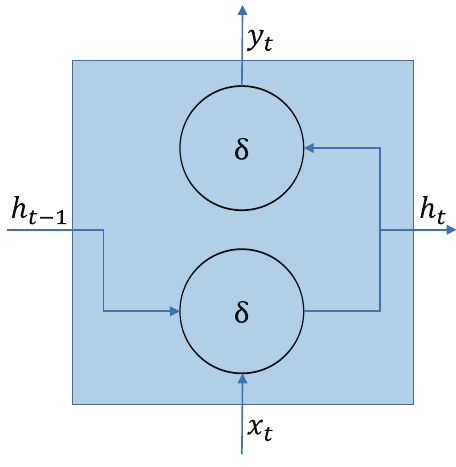
Figure 2. Schematic of an RNN node